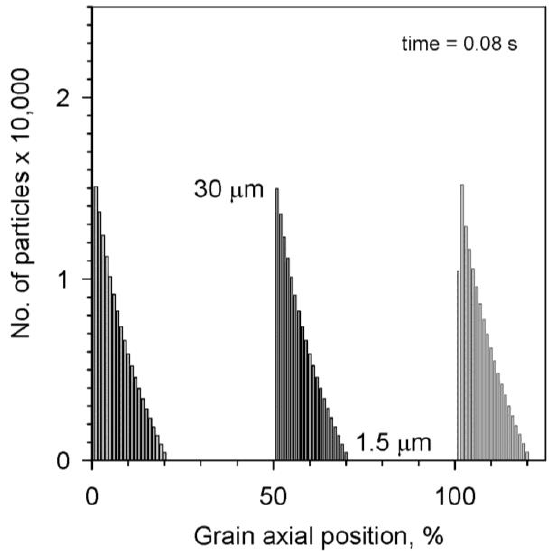
Figure 8. For the simulated firing of Figure 7, the particle size distribution in the element, at different positions along the propellant grain, before the introduction of the initial pressure pulse